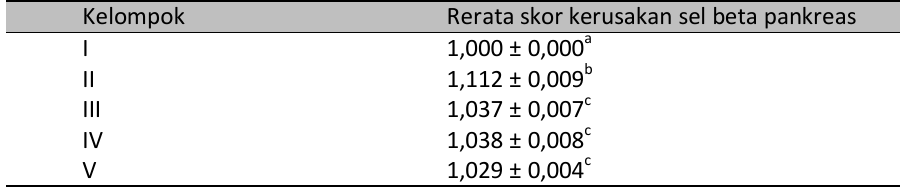
Tabel 2. Rerata skor kerusakan sel beta